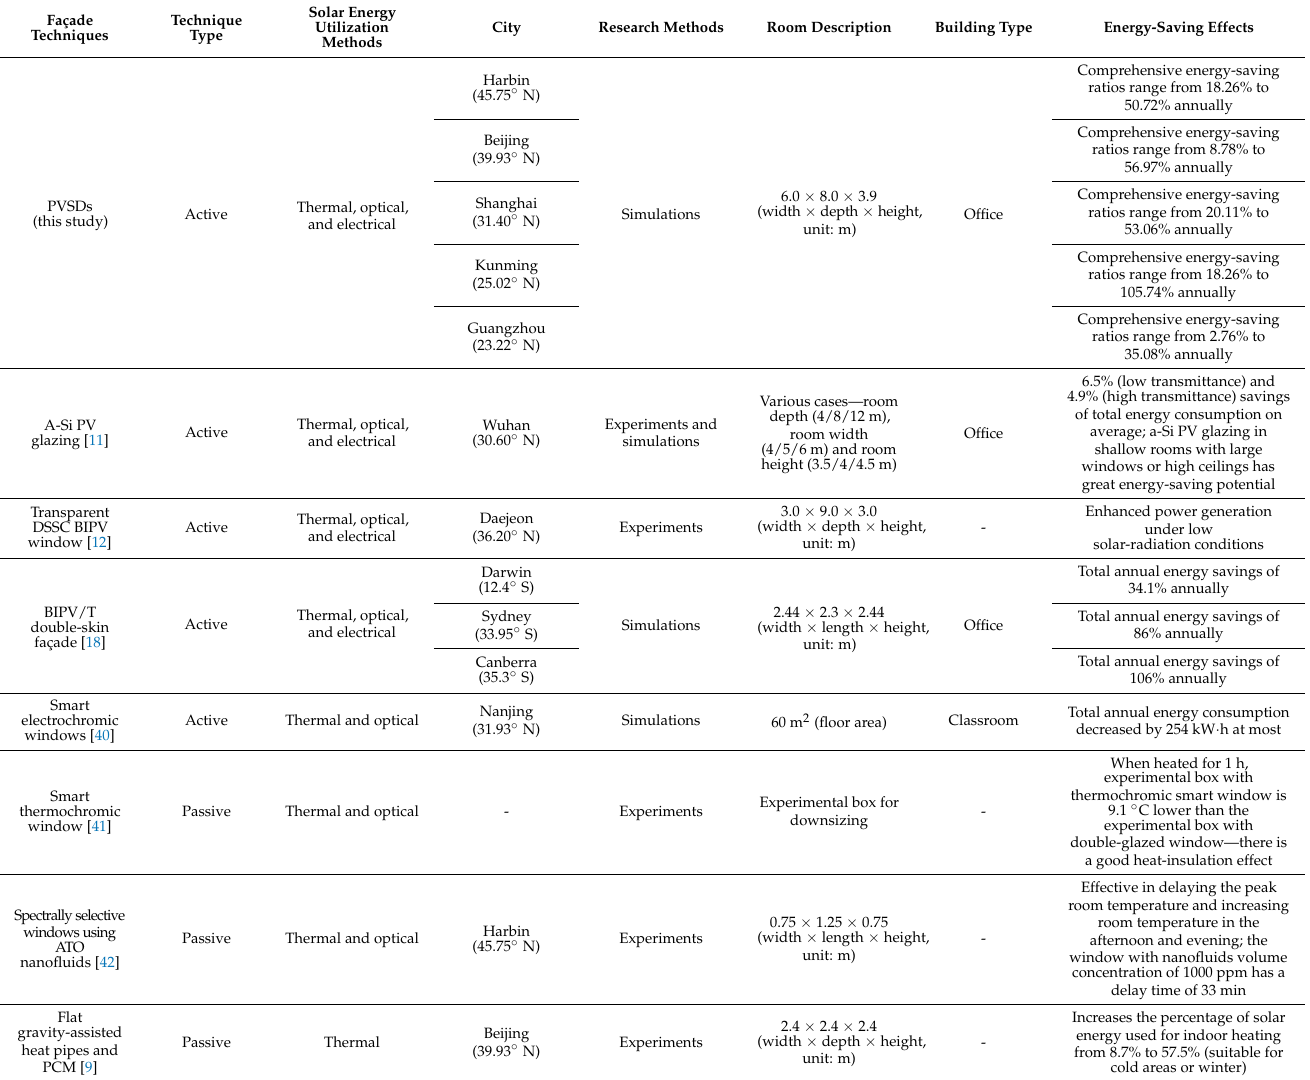
Table 5. Comparison of PVSDs and other